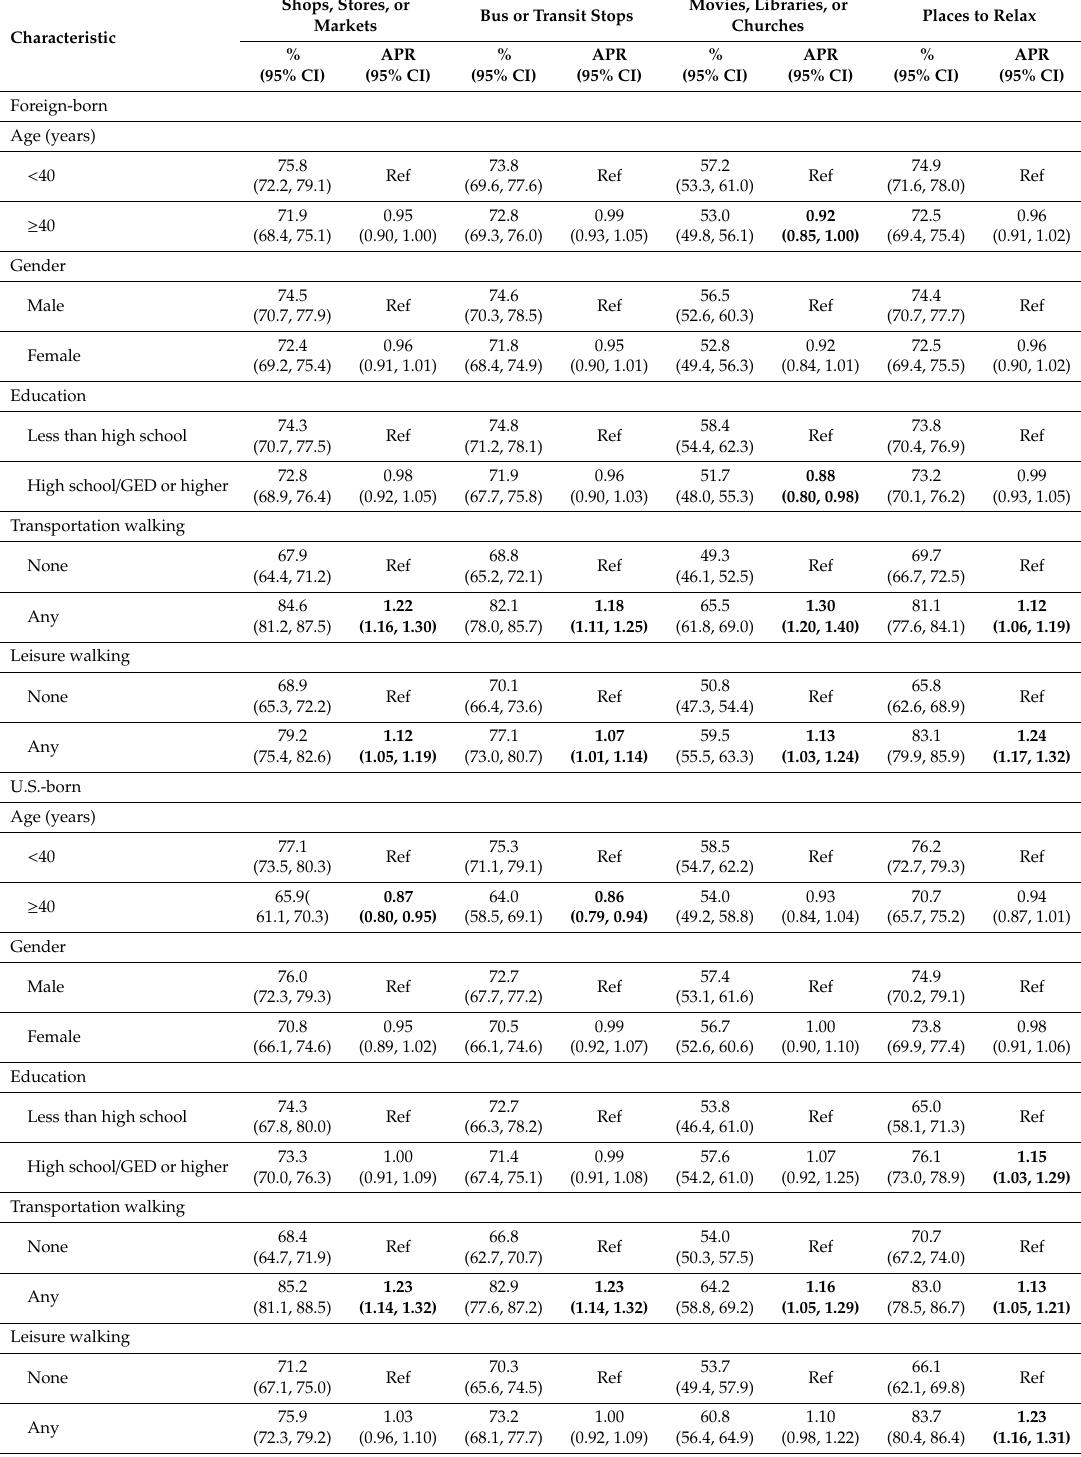
Table 4. Multivariate associations of socio-demographic characteristics and walking behaviors with perceived neighborhood destinations among Latinos, stratified by nativity, the NHIS